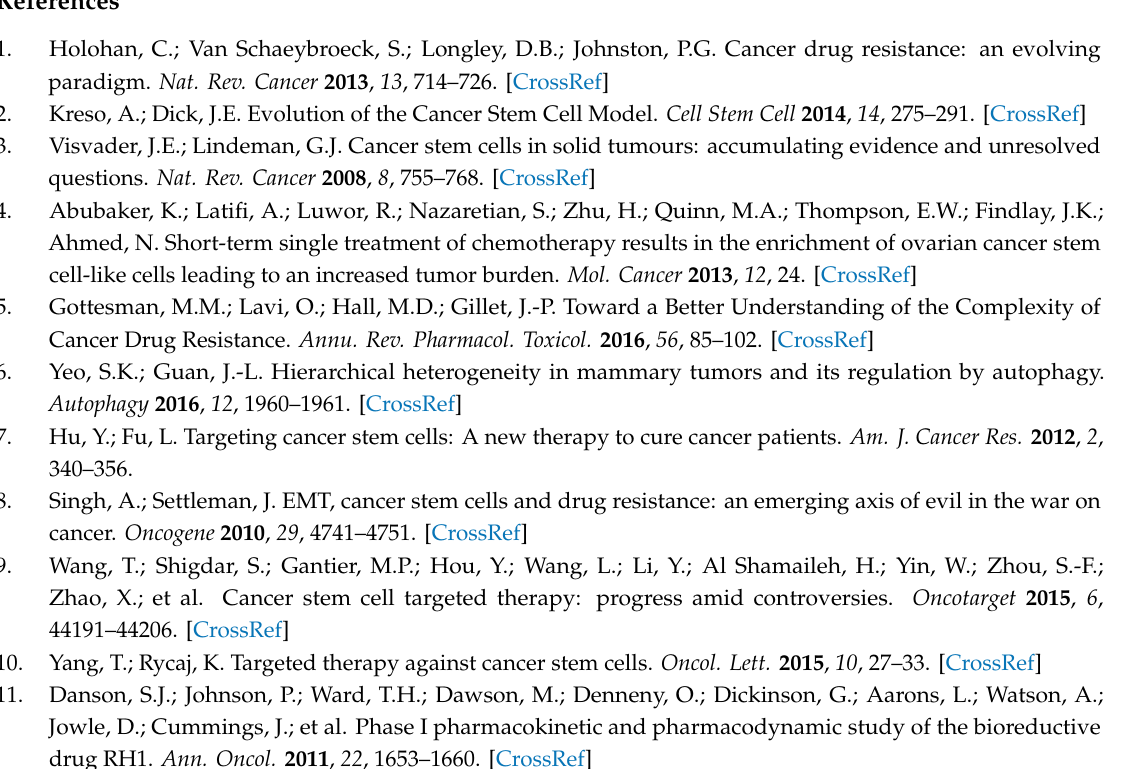
Table S1: Proteins identified in HDMS analysis, Table S2: Proteins comprising main functional clusters, Table S3: List of kinases and other proteins precipitated with MIBs, Table S4: List of di ff erentially phosphorylated peptides, Figure S1: RH1 treatment a ff ects breast cancer cell cycle, Figure S2. AKT phosphorylation is increased in RH1-resistant cells, Figure S3: Whole western